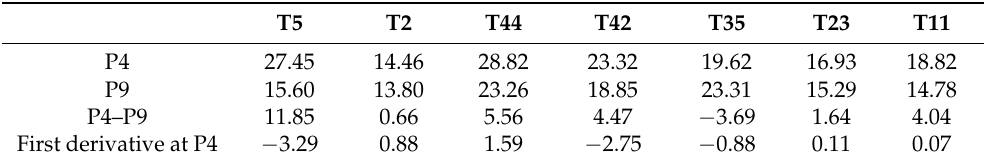
Figure 6. Average HNR track of the seven tones in Xiapu Min. Table 8. HNR value at P4 and P9, the difference in HNR between P4 and P9, and the first derivative of the HNR contour at